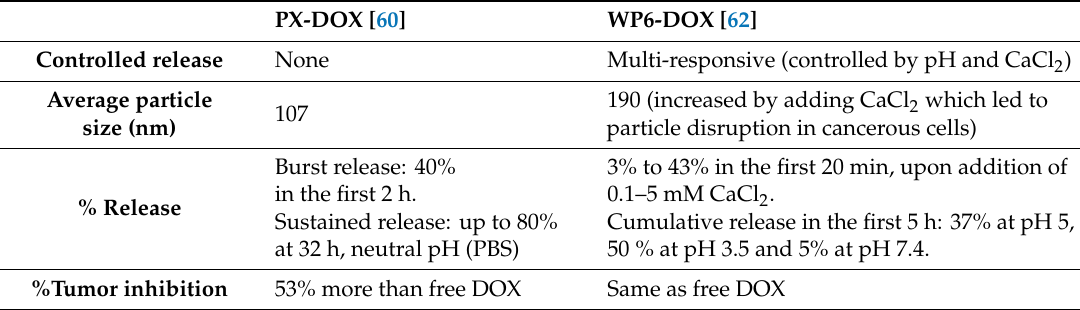
Table 4. Di ff erences between polyrotaxanes (PX)-DOX and water soluble pillar[6]arene (WP6)-DOX in terms of controlled release, size, %EE, % release and % tumor inhibition. PBS: phosphate bu ff er saline